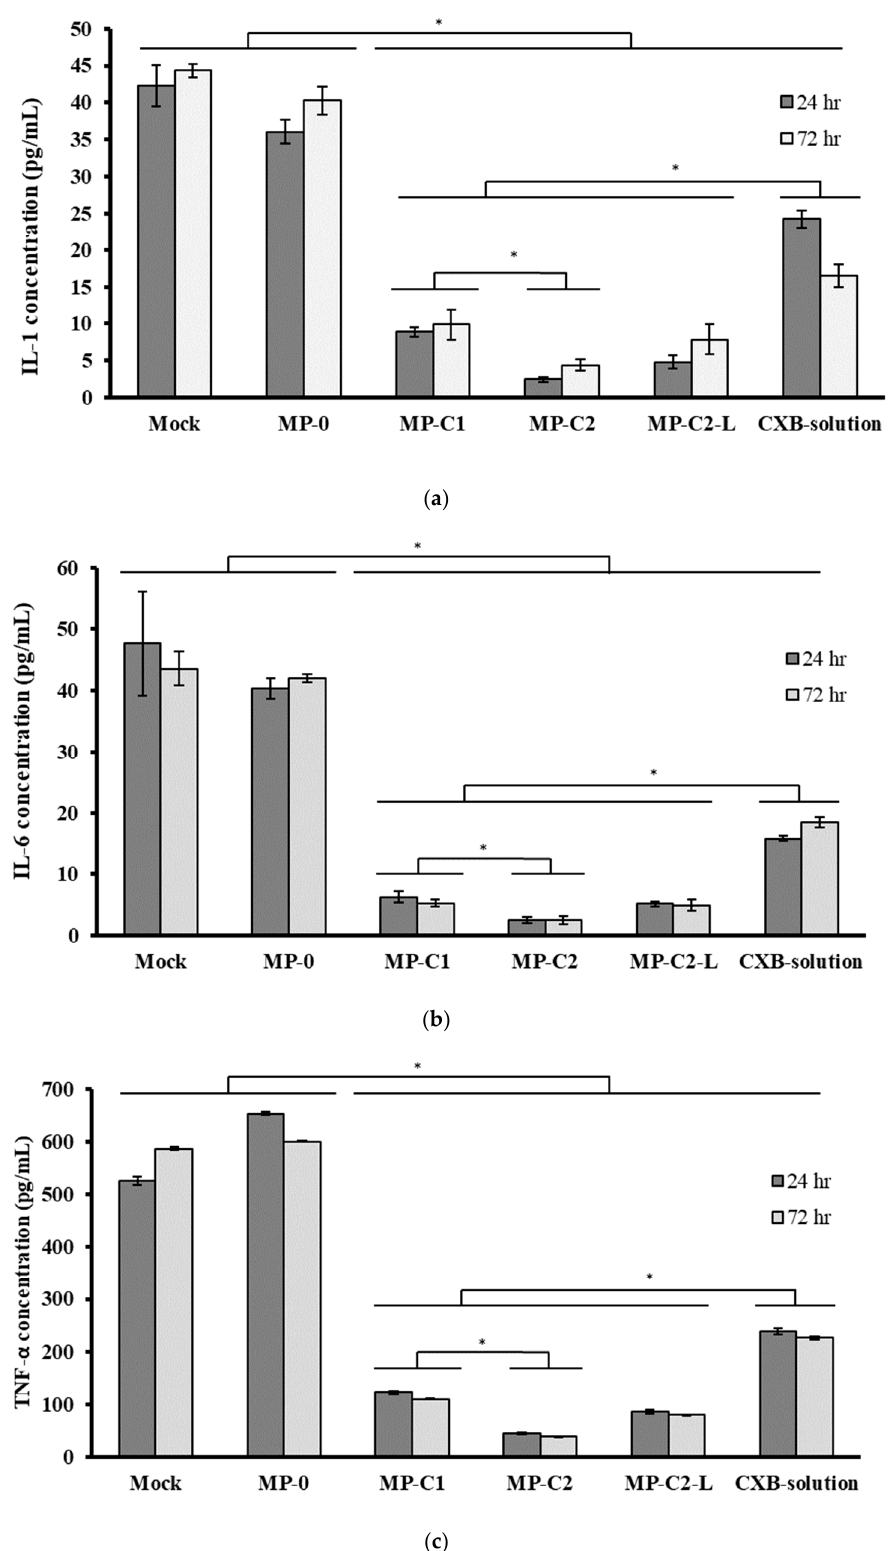
Figure 7. Mean concentrations (±SD) of ( a ) IL-1, ( b ) IL-6 and ( c ) TNF- α obtained after incubating macrophages with formulations MP-0, MP-C1, MP-C2, MP-C2-L and CXB solution for 24 h and 72 h. Mock: control cells. * p < 0.05.